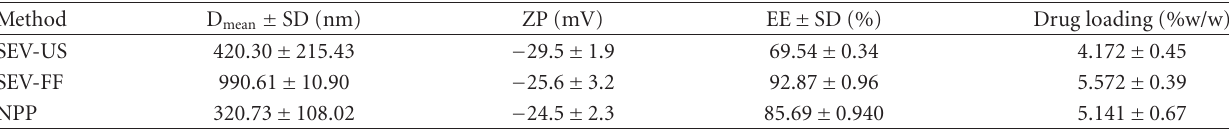
Table 3: Optimized formulations: influence of production method ( n = 6) (initial amount of CB13 (6%w/w).